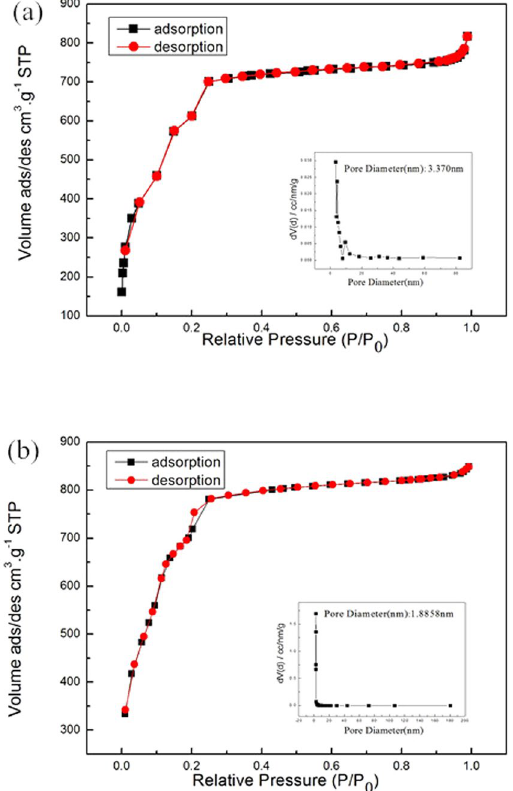
Figure 6. Nitrogen adsorption/desorption isotherm and Barrett-Joyner-Halenda (BJH) pore size distribution plot (inset) of ( a )MIL-101(Fe) and ( b )NH 2